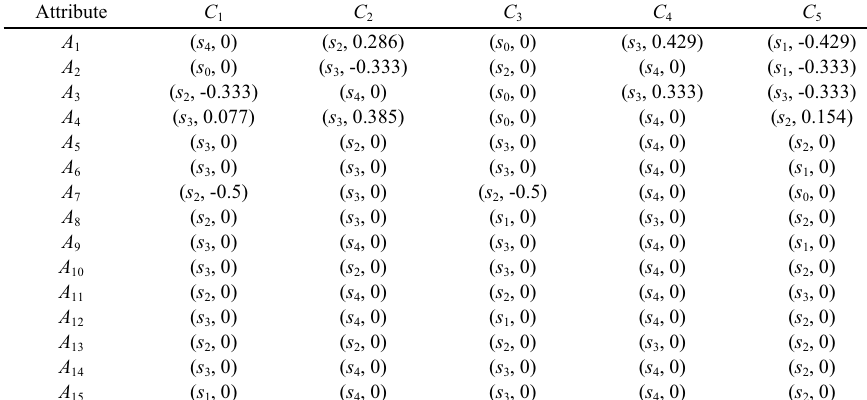
Table 10. Linguistic 2-tuple decision matrix